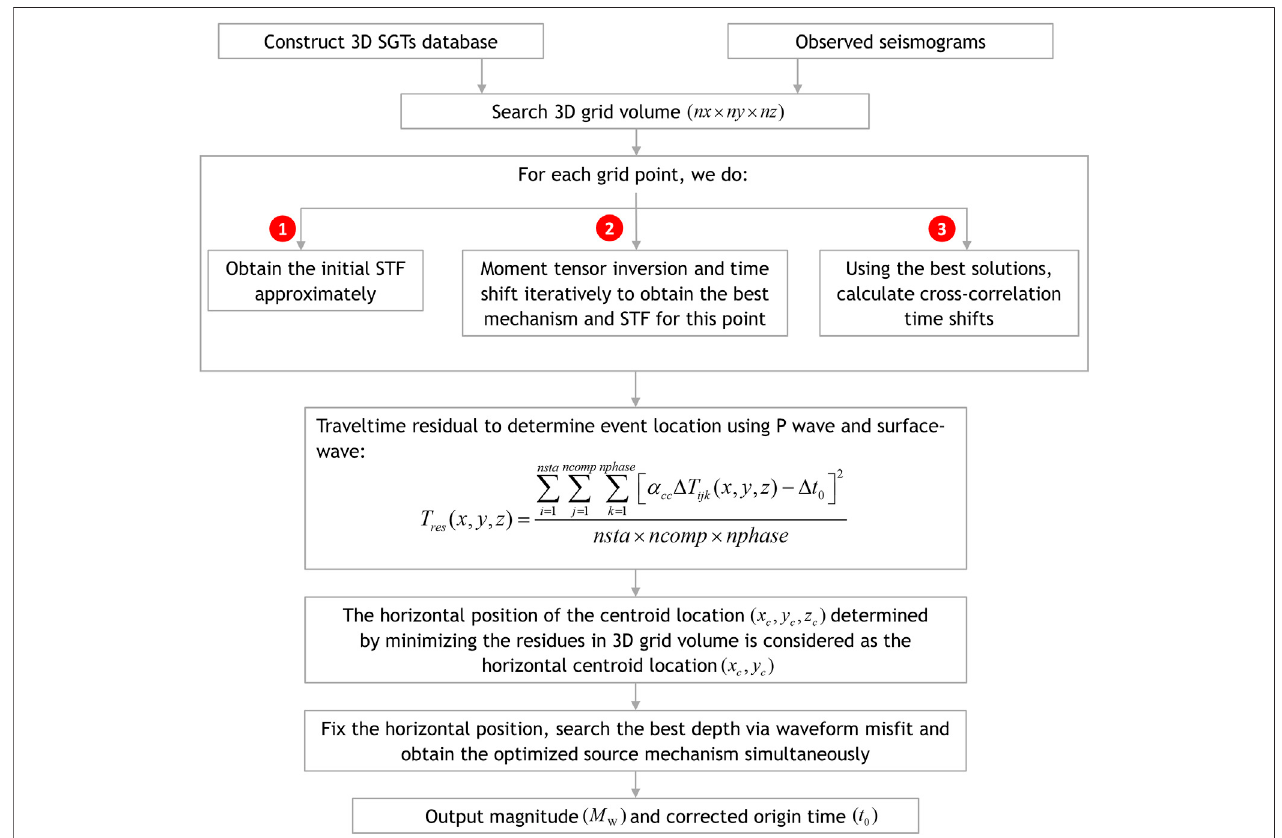
FIGURE 1 | The brief inversion work fl ow for the source